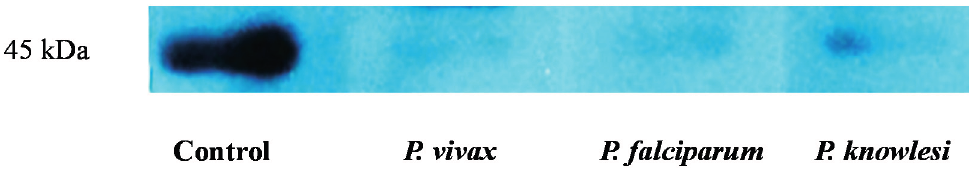
Figure 2. Western blot validation of downregulated HAP in malaria